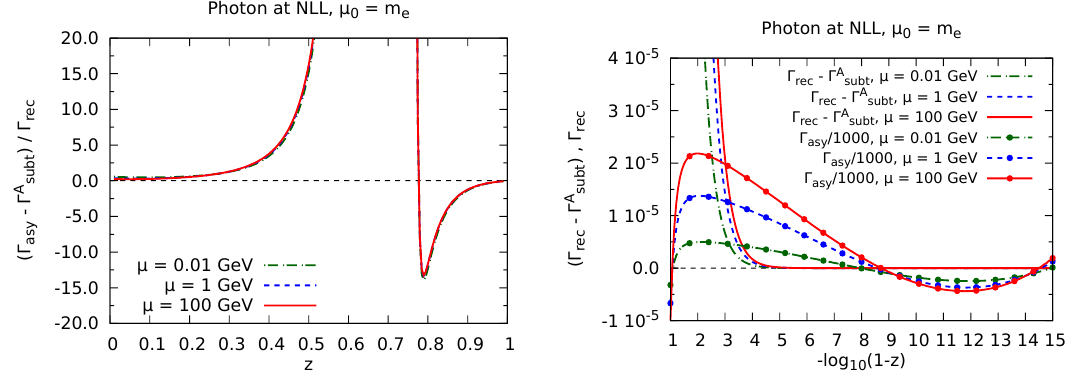
Figure 3 . Plots assessing the validity of eq. (7.10) (left panel) and eq. (7.8) (right panel), in the case of the photon PDF. See the text for